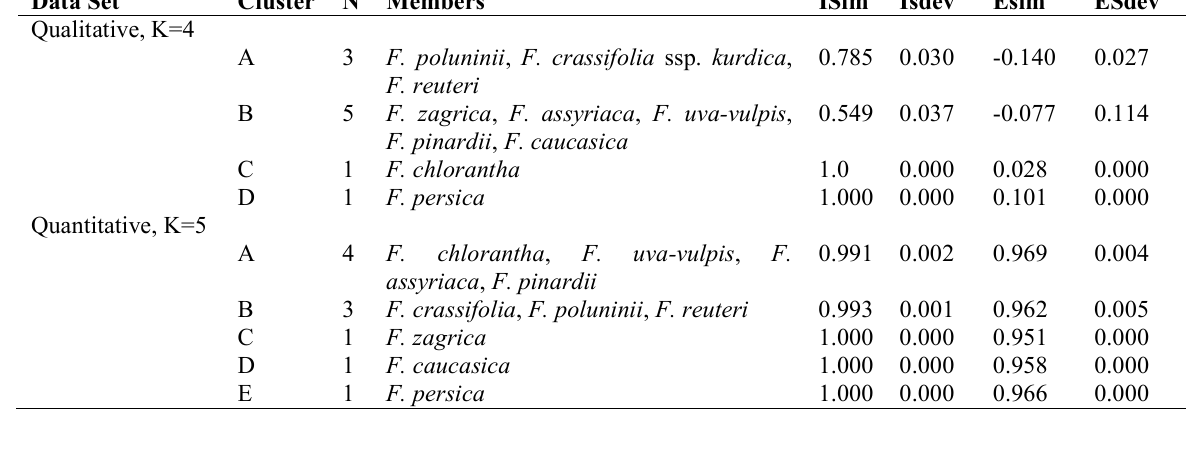
Table 5. K means clustering. Internal and external similarity measures of groups and membership of taxa in each cluster corresponding to Fig. 5.